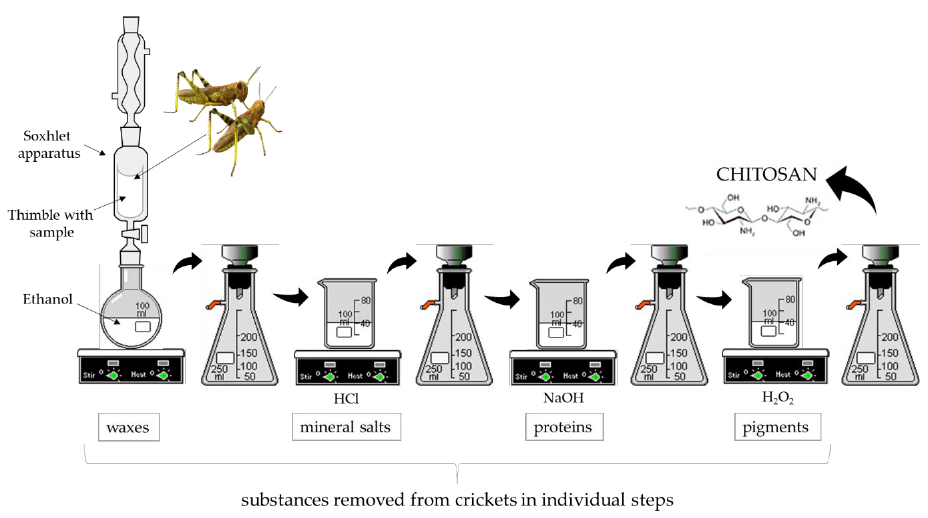
Figure 1. A scheme of the chemical treatment of crickets leading to the preparation of chitosan.